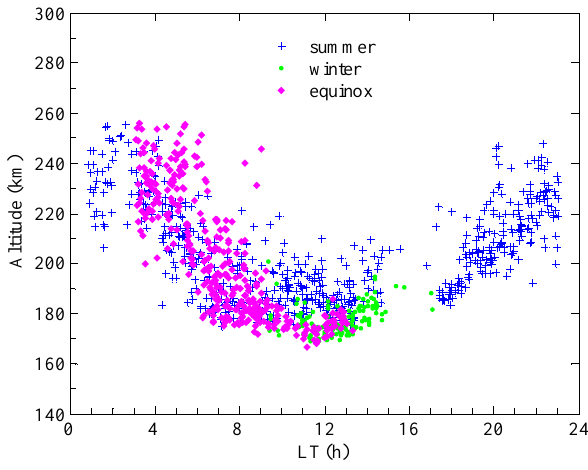
Figure 5. The diurnal and seasonal variation of LTH derived from Atmosphere Explorer-C.